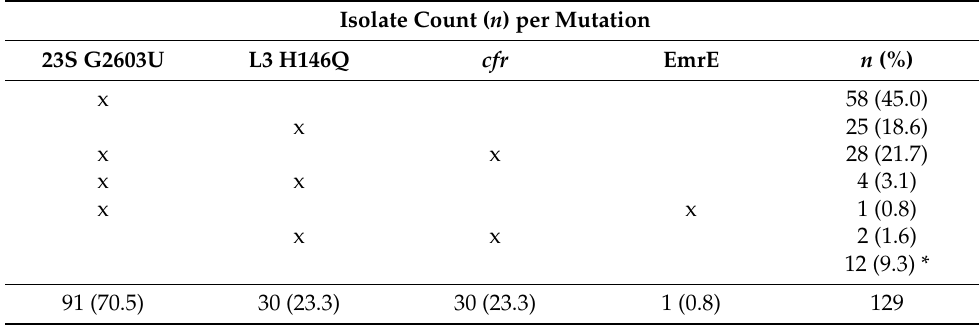
Table 1. Emergence of linezolid resistance mechanisms within investigated linezolid-resistant Staphy- lococcus epidermidis (LRSE) isolates. Percentages are given in